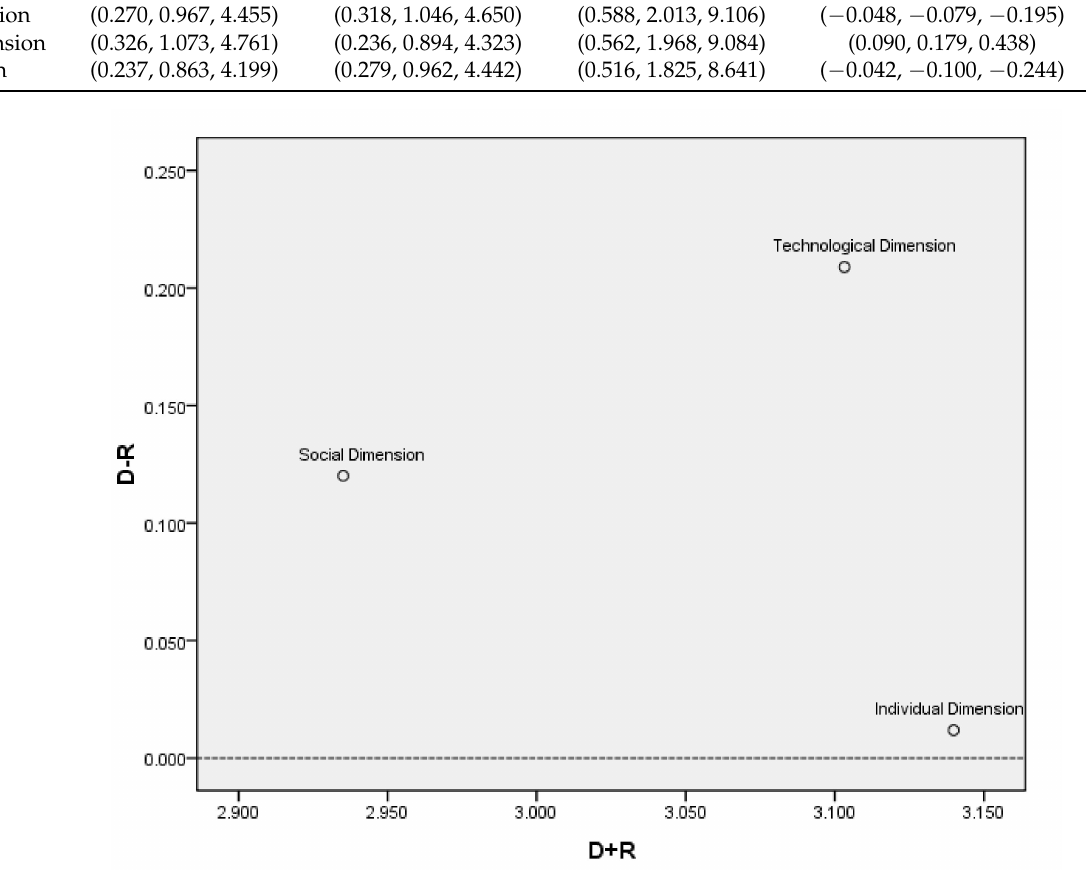
Figure 2. Graph of appearing causal relations among three